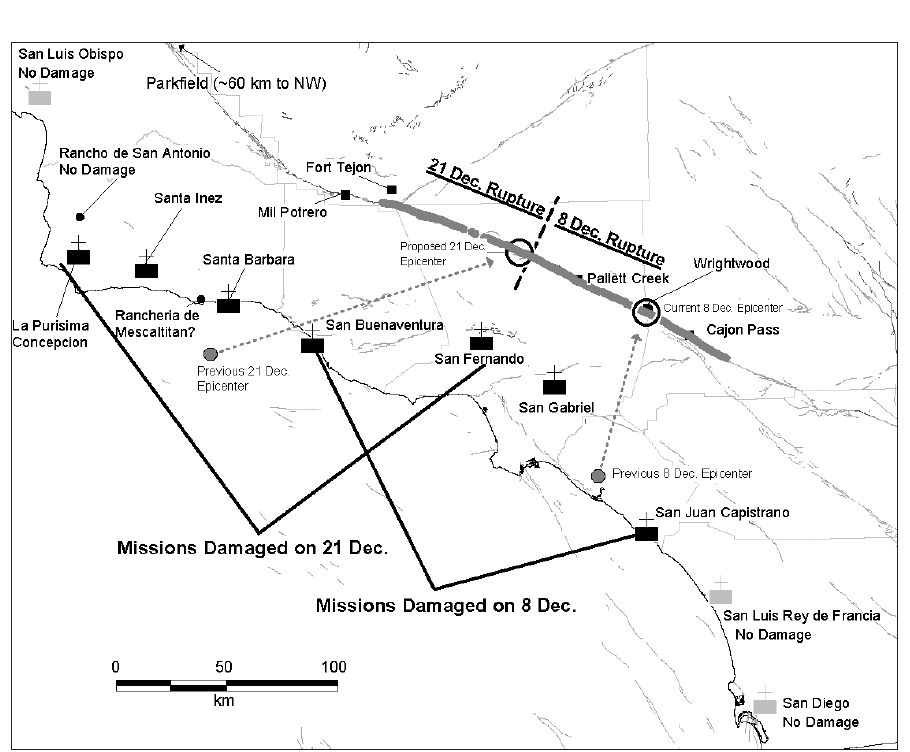
Fig. 7. Missions damaged by the December 1812 earthquakes. We divide the 1812 rupture proposed by Jaco- by et al . (1988) into 2 segments to account for the damage observed on 8 and 21 December, and on both dates (modified from Toppozada et al .,